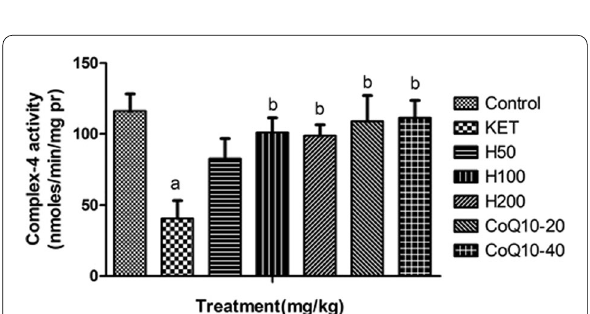
Fig. 16 Effect of hesperidin and Coenzyme Q10 on complex III enzyme (cell viability assay or MTT assay) activity in the hippocampus region of the brain. Data were analyzed by one-way ANOVA followed by Tukey’s post hoc analysis. All values were expressed as Mean SEM. a p < 0.05 as compared to naive, b p < 0.05 as compared to ± ketamine. KET, Ketamine; H, Hesperidin; CoQ10, Coenzyme Q10